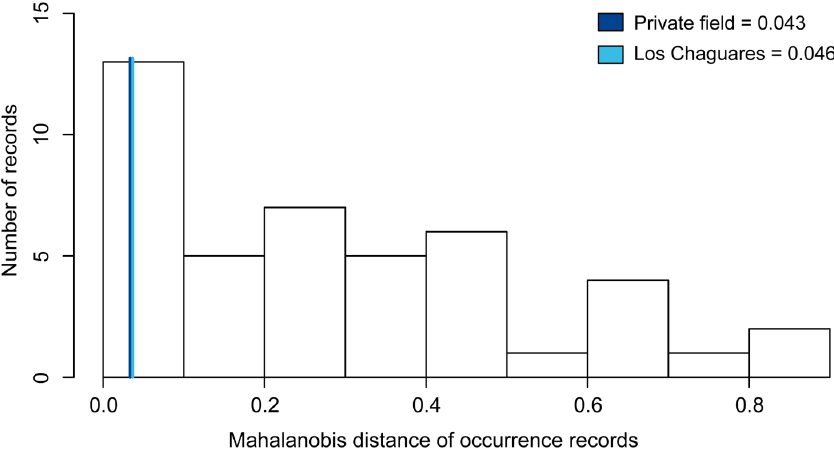
Figure 2. Histogram shows Mahalanobis distance of occurrence records to the ellipsoid centroid of Lepturges limpidus . Values associated with the new distributional records reported in the present study are indicated in blues lines, Line dark blue represents “Private field” and Line light blue represents “Los Chaguares”.